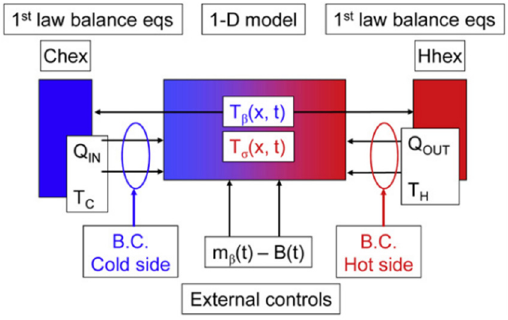
Figure 34. Conceptual scheme of the AMRR model [61].